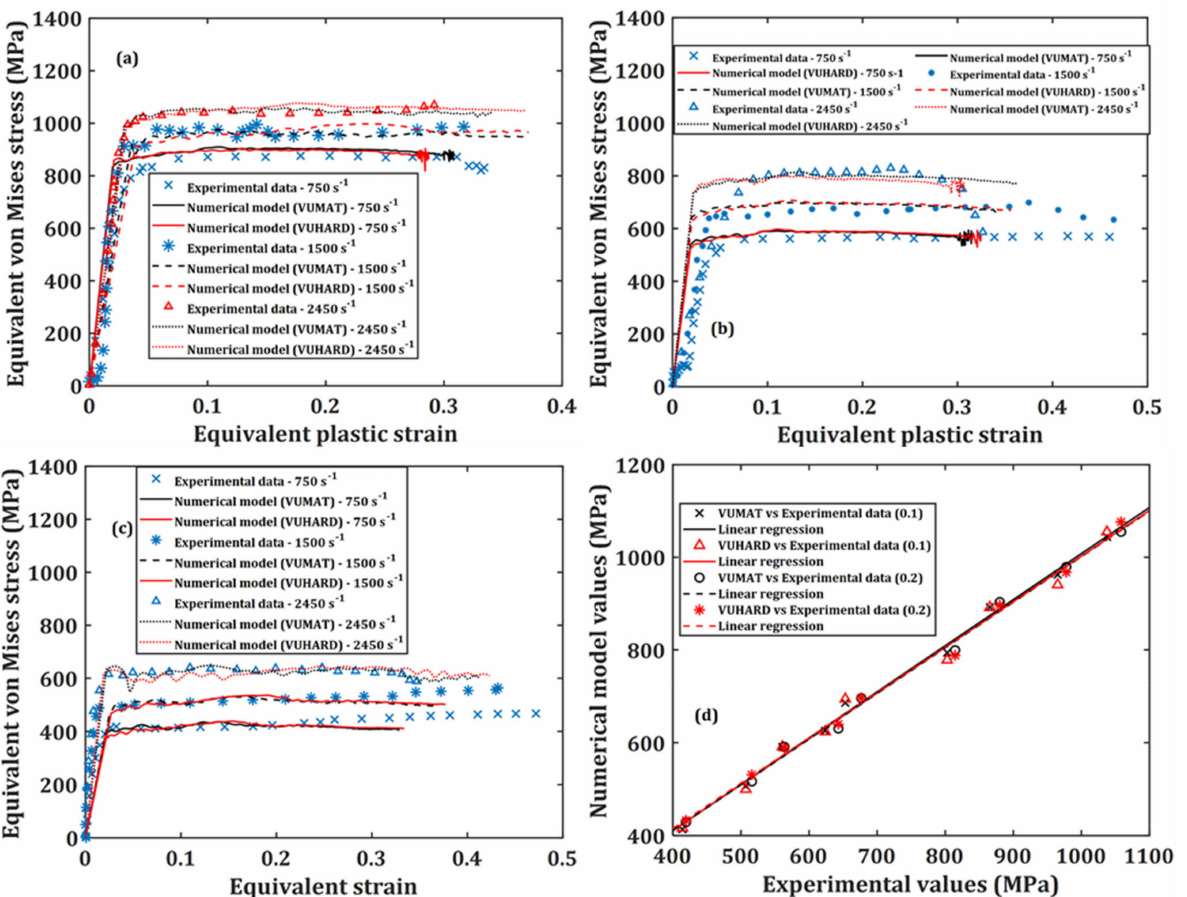
Figure 9. Graphs of the numerical model prediction and the experimental results for samples D, at three high strain rates and at temperatures of ( a ) 25 ◦ C; ( b ) 200 ◦ C and ( c ) 500 ◦ C; and correlation between the numerically predicted values and those obtained from experimentation at strains of 0.1 and 0.2 in ( d